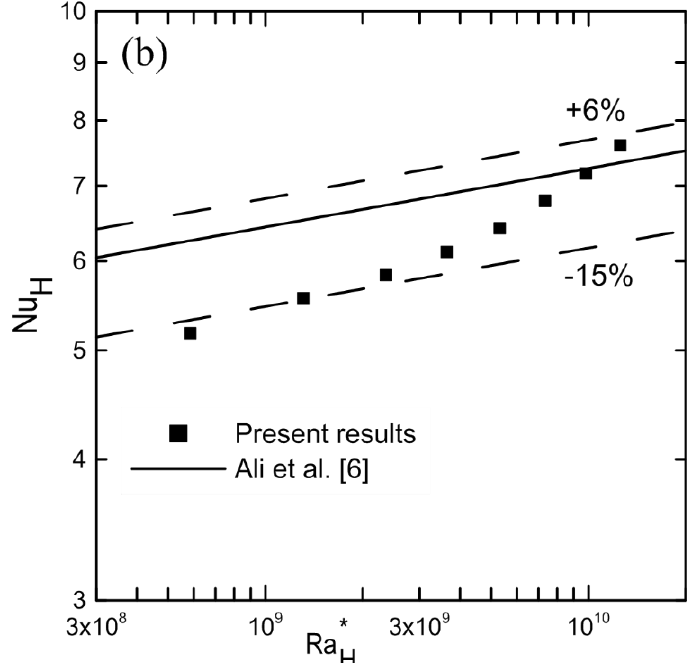
Figure 12. Comparison with previous results: ( a ) with [35] at a 30° angle; ( b ) with [6] for a horizontal cavity ( φ = 0°).